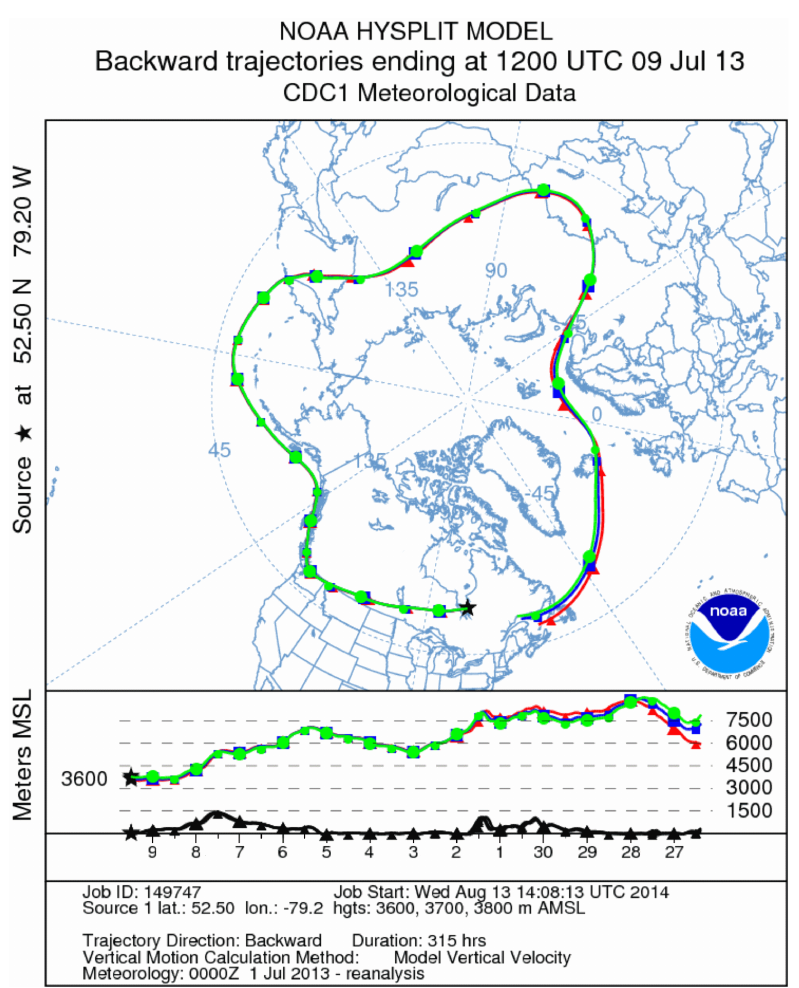
Figure 18. Extension backward trajectories for those in Fig. 17 initiated on 9 July 2013 (12:00UTC) at altitudes of 3600, 3700 and 3800ma.s.l. over James Bay where the three trajectories in Fig. 17 almost coincide. The coherence of the trajectory bundle is exceptional. The maximum altitude reached is about